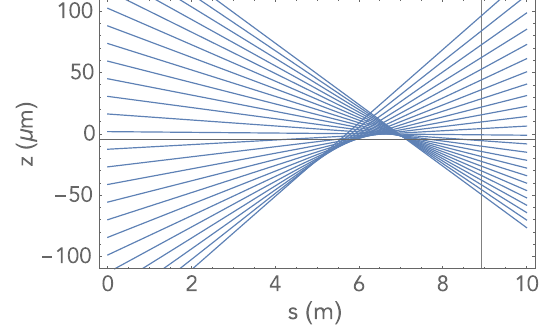
15.FIG. 15. Electron trajectories s – z space, where the gray vertical line indicates the end of the compressor where the current profile is evaluated.